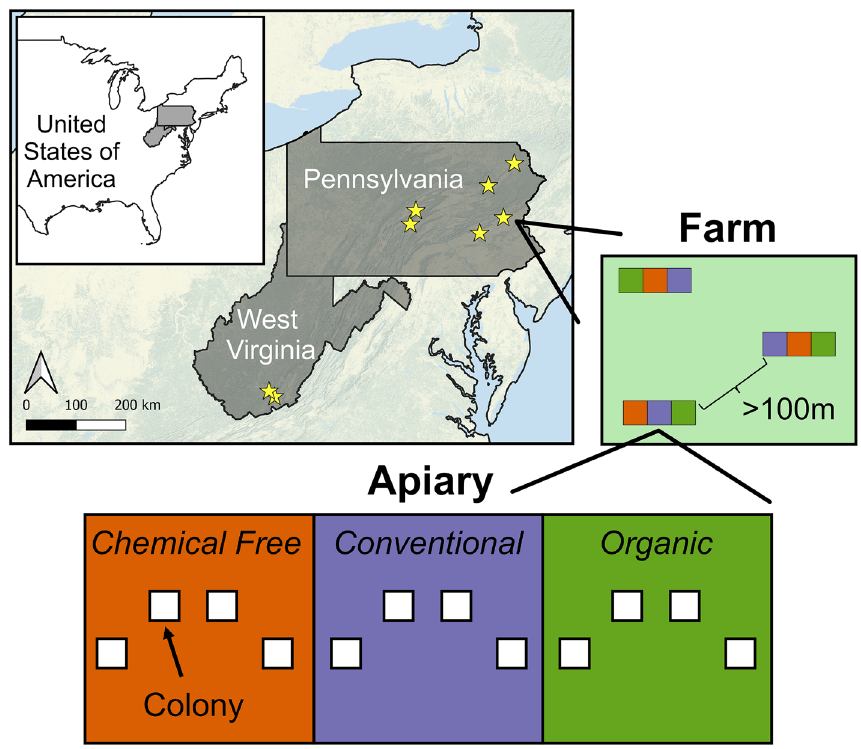
Figure 1. Geographic locations and spatial distribution of farms, apiaries, and colonies. The yellow stars represent the different farm locations. Each farm housed three apiaries at least 100 m apart that contained a total of 12 colonies, 4 in each management system. The spatial arrangement of the different treatments was randomly assigned across